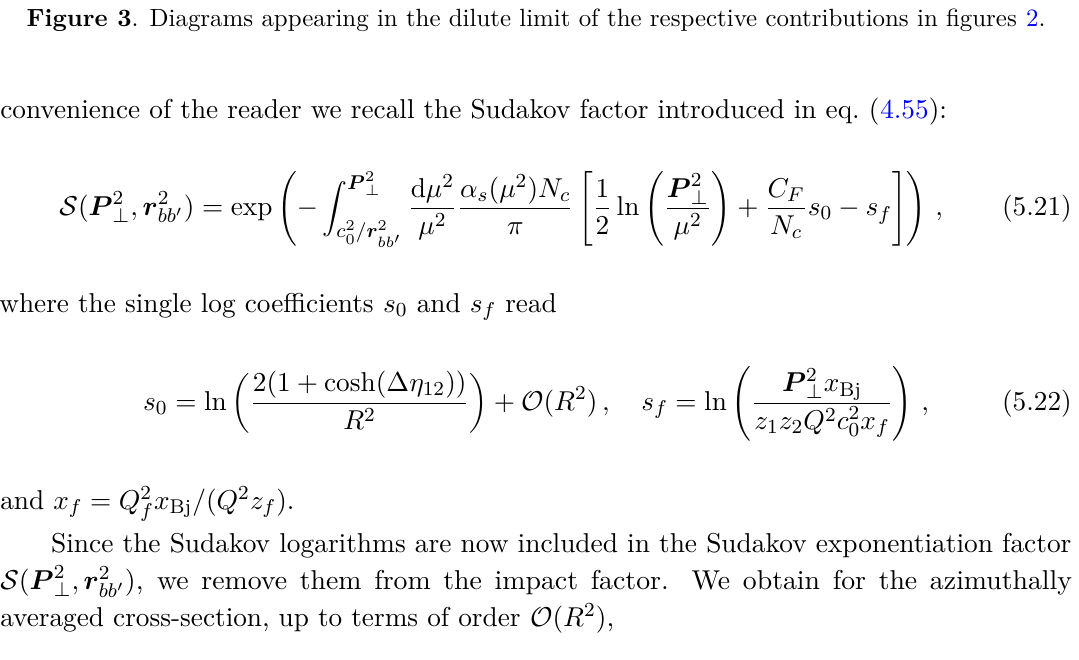
Figure 3 . Diagrams appearing in the dilute limit of the respective contributions in figures